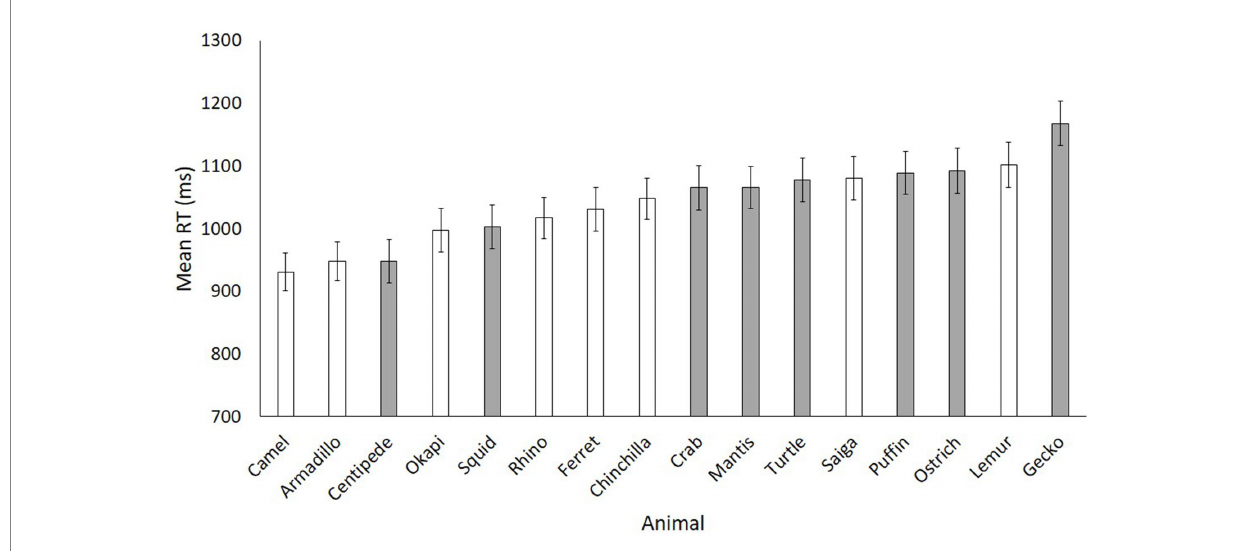
FIGURE 3 Mean reaction times for each animal in Experiment 1. Mammals are white, non-mammals are grey. Error bars represent standard